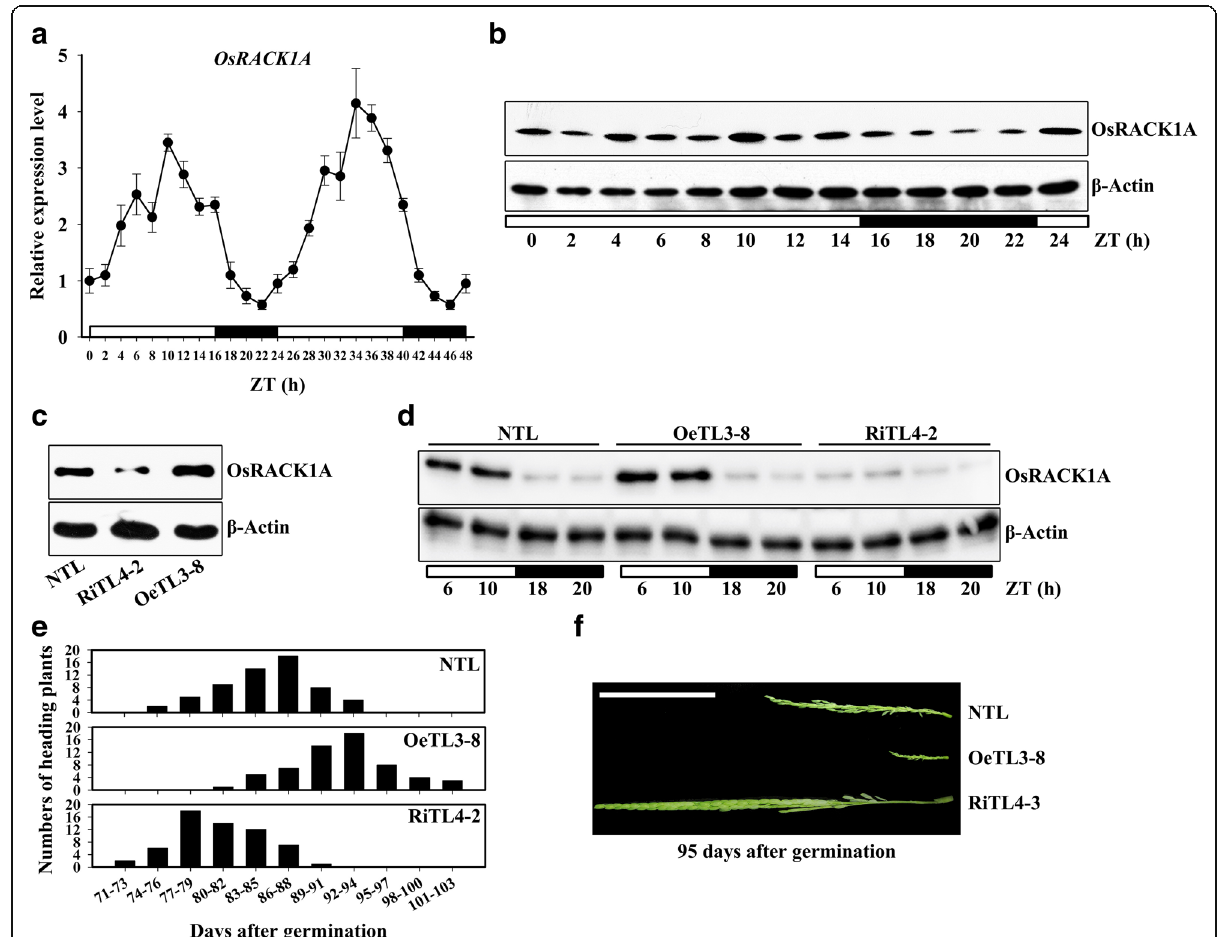
Fig. 1 Circadian clock-controlled OsRACK1A expression in rice. a Transcript analysis of the OsRACK1A gene by qRT-PCR over a 48-h period. Rice plants were grown under 16 h light and 8 h dark in a growth chamber at a constant temperature of 28 °C and sampled at regular intervals. b Immunoblot analysis of OsRACK1A protein over a 24-h period. c OsRACK1A expression was monitored by immunoblot analysis in seedlings of a non-transgenic line (NTL), an OsRACK1A -overexpressing transgenic line (OeTL3 – 8), and an RNA-interfered transgenic line (RiTLs4 – 2). d Protein levels of OsRACK1A in NTL, OeTL3 – 8 and RiTLs4 – 2 in light and dark. e Heading time distributions in transgenic rice plants grown in the field. During the heading period, the number of heading plants for each line was recorded every 3 days and compared. f Phenotypic comparison panicles during the heading period of transgenic plants. The rice plants had been grown in the field for 89 d. ZT, Zeitgeber Time. White and black rectangles indicate lights on and lights off,